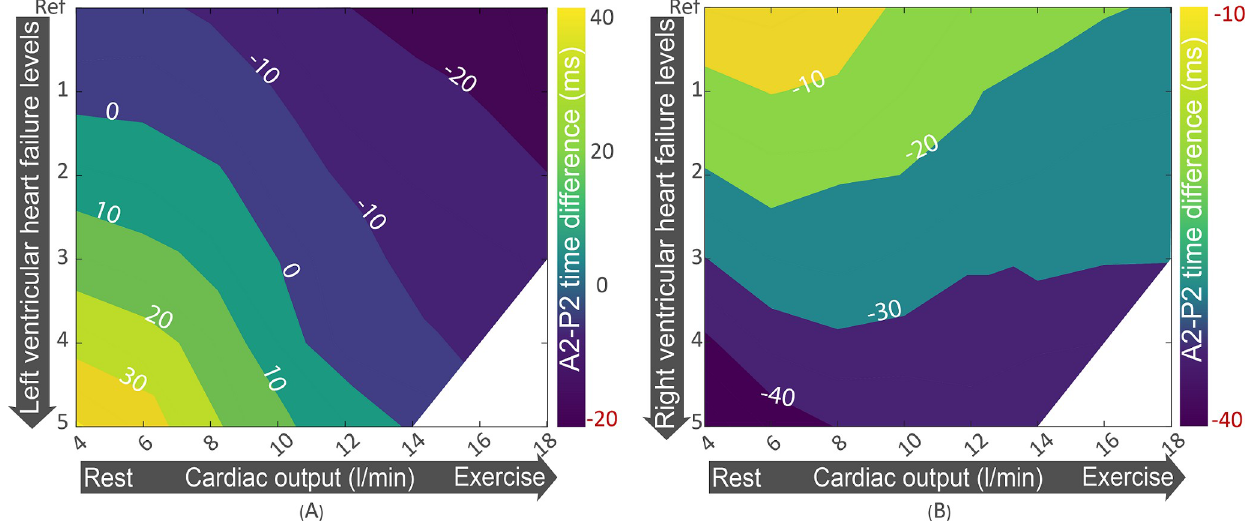
Fig 7. (a) A2-P2 splitting interval for left ventricular heart failure of various severity levels and exercise levels. (b) A2-P2 splitting interval for right ventricular heart failure of various severity levels and exercise levels. Positive values indicate reverse splitting.